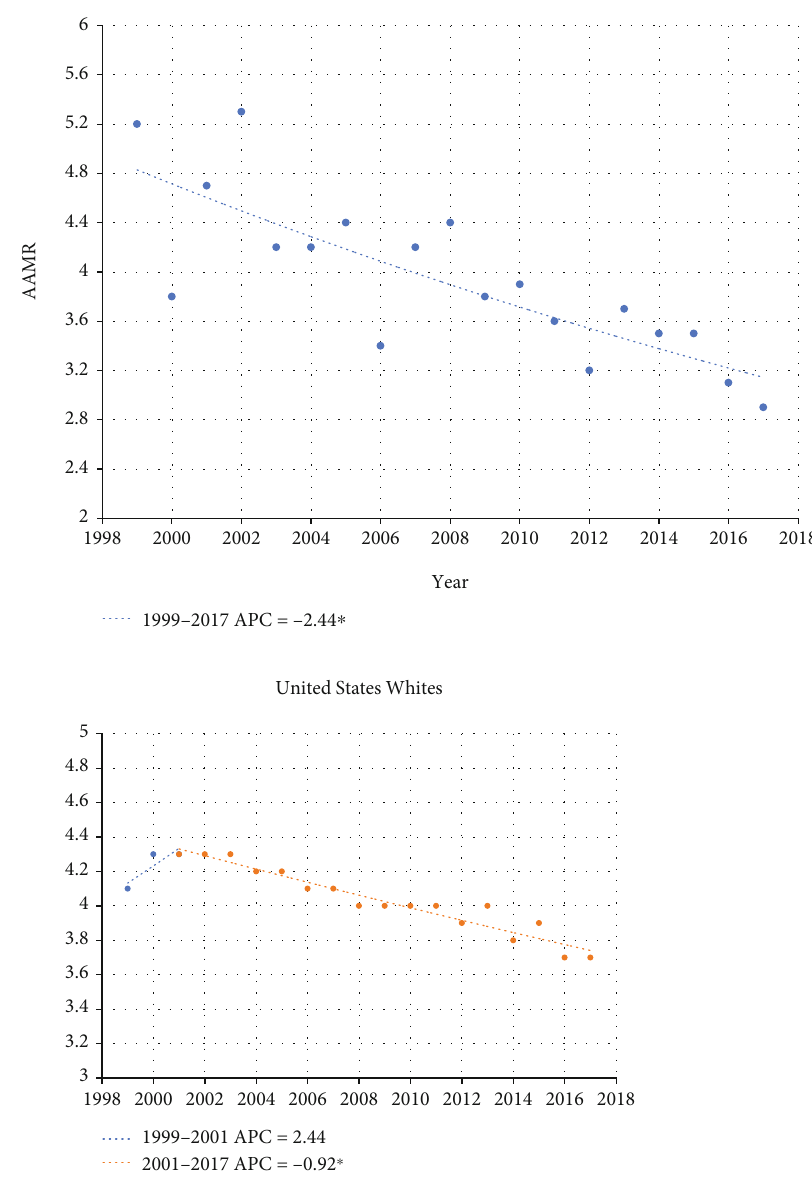
Figure 4: Joinpoint regression comparing AAMR between United States AI/ANs and Whites over time (rates per 100,000 population). ∗ Indicates that the annual percentage change (APC) is signi fi cantly di ff erent from zero at the alpha = 0 : 05